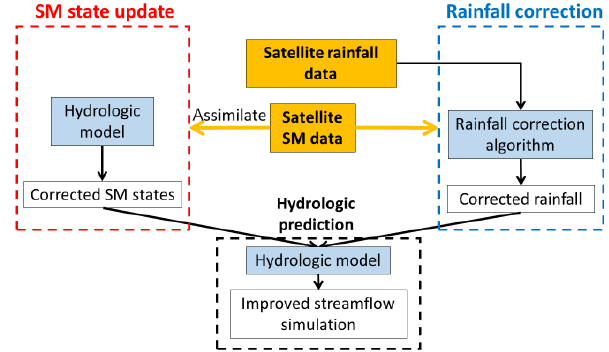
Figure 1. The dual state/rainfall correction framework applied in this study. Satellite-based soil moisture (SM) data are integrated into a hydrological simulation system via two correction schemes: (1) a standard data assimilation system to correct modeled SM states (shown in the red box on the left) and (2) a rainfall correction al- gorithm to correct rainfall forcing data (shown in the blue box on the right). Finally, these two contributions are combined to improve streamflow simulations (shown in the black box at the